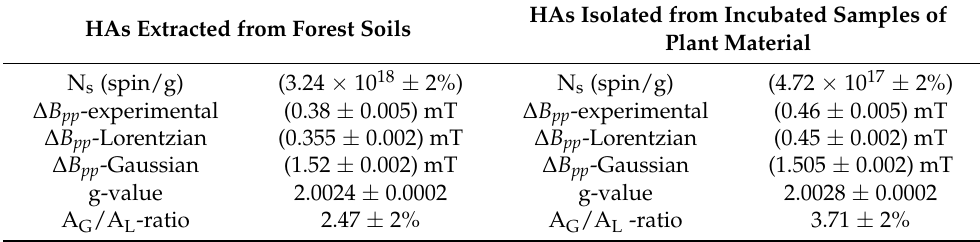
Table 2. The parameters of the EPR lines (average values of EPR spectra of the measured values along with standard deviations).